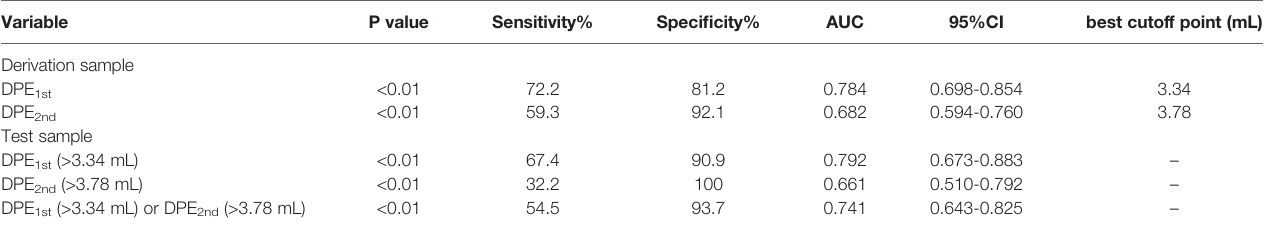
TABLE 2 | Predictive Values of DPE for The Identi fi cation of Patients with Poor Prognosis in The Derivation Sample and The Test Sample. Variable